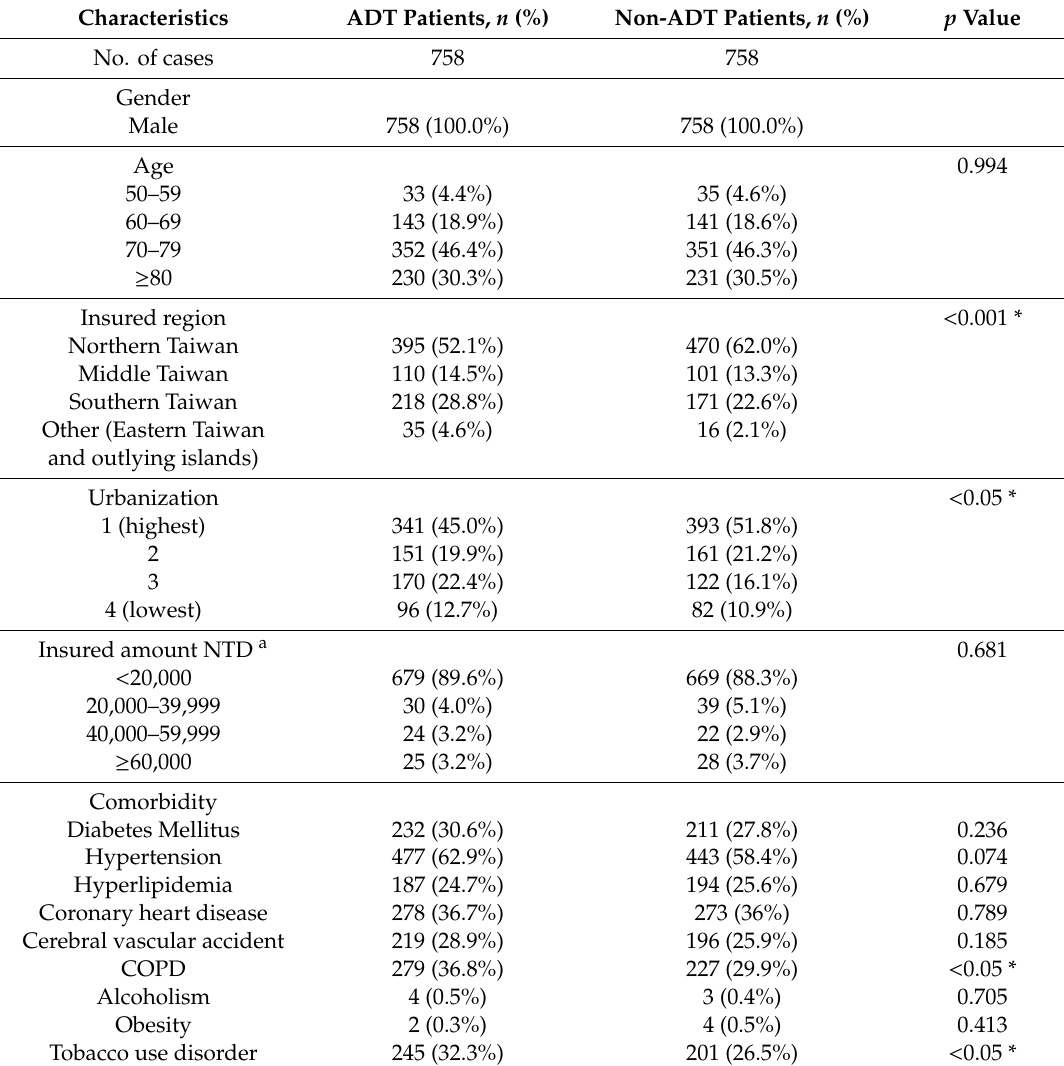
Table 1. Demographic and medical characteristics of prostate cancer patients according to androgen deprivation